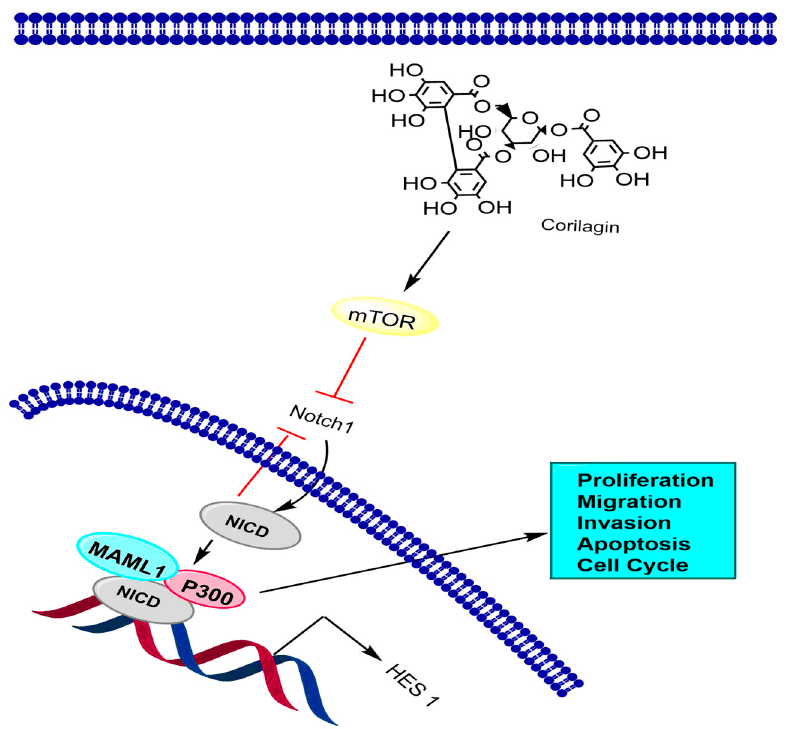
Figure 3. The e ff ect of corilagin on the Notch-mTOR signaling pathway in cholangiocarcinoma. NICD Figure 3. The effect of corilagin on the Notch-mTOR signaling pathway in cholangiocarcinoma. is notch intracellular NICD is notch intracellular domain.